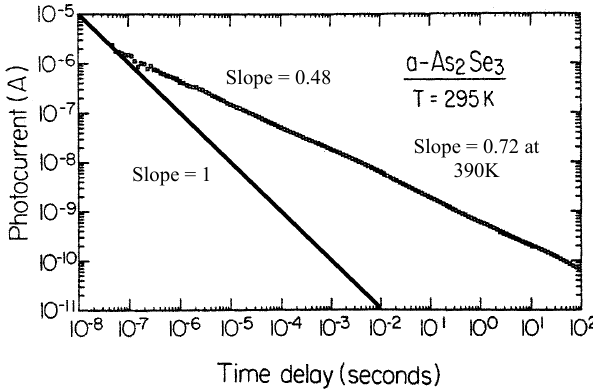
Figure 12. Band tail photocurrent in As 2 Se 3 glass. i = at α , the exponent varies on T as ( T − T 0 )/ T 0 . A Poisson distribution of trapping sites is deduced.